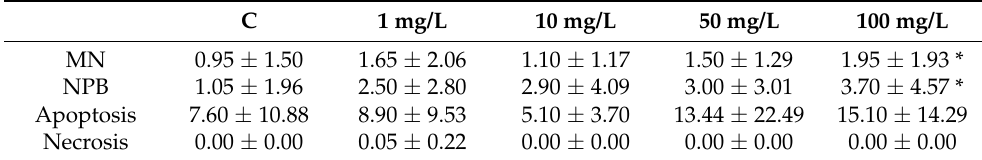
Table 1. Frequency (‰) of Micronucleated cells (MN), Nucleoplasmic Bridges (NPB), apoptotic cells, and necrotic cells in zebra mussel haemocytes after exposure to different nominal doses of Zn(II): 1 mg/L/, 10 mg/L, 50 mg/L, 100 mg/L. (*) indicates significant differences respect to the control